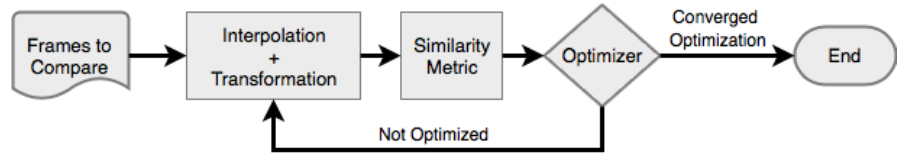
Figure 3. Iterative image registration